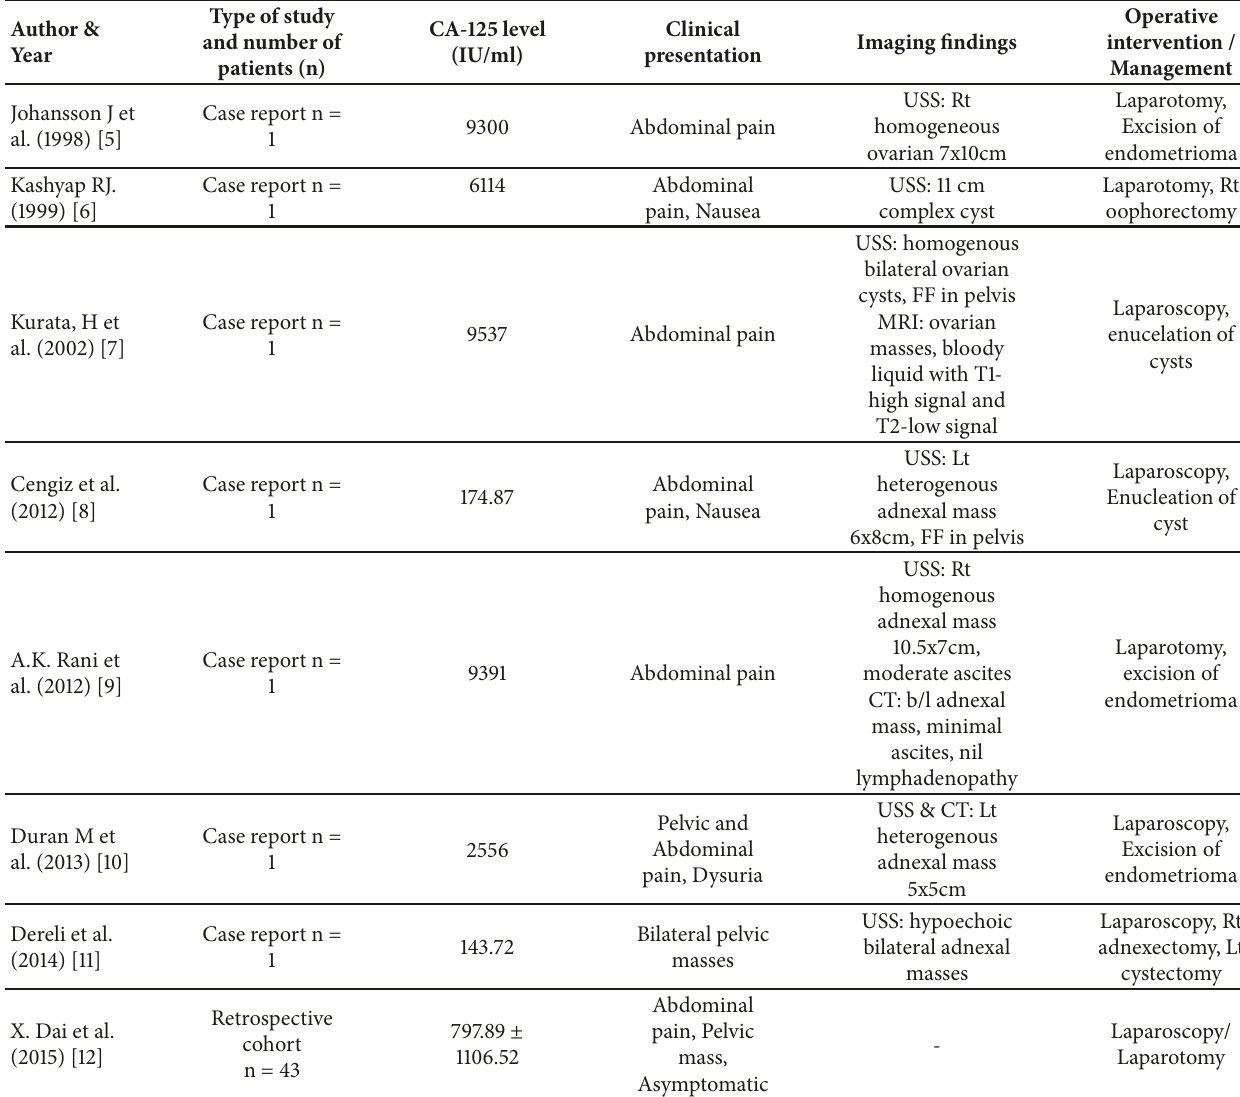
Table 1: Summary of cases of ruptured endometrioma with elevated CA 125 levels †